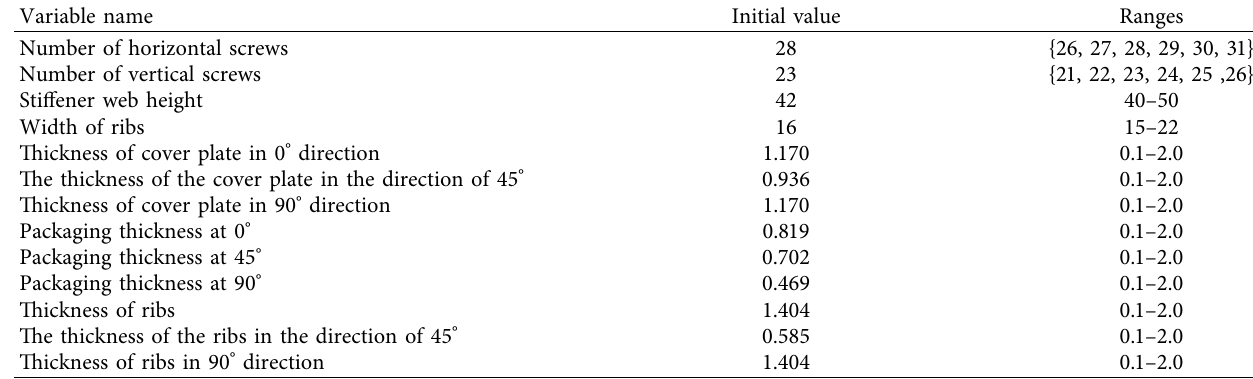
Table 5: Design variable value